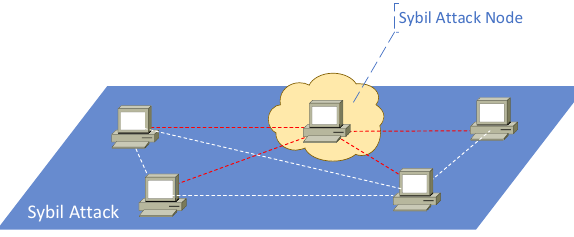
Figure 5. Sybil attack diagram.